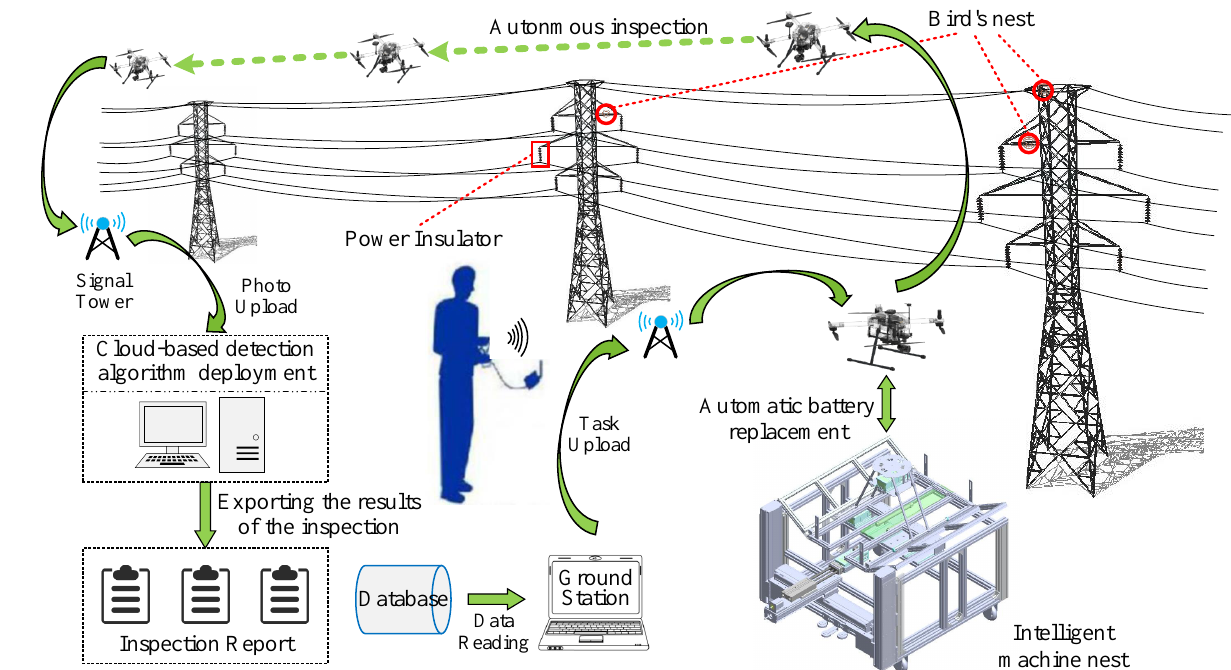
Figure 2. The structure of the